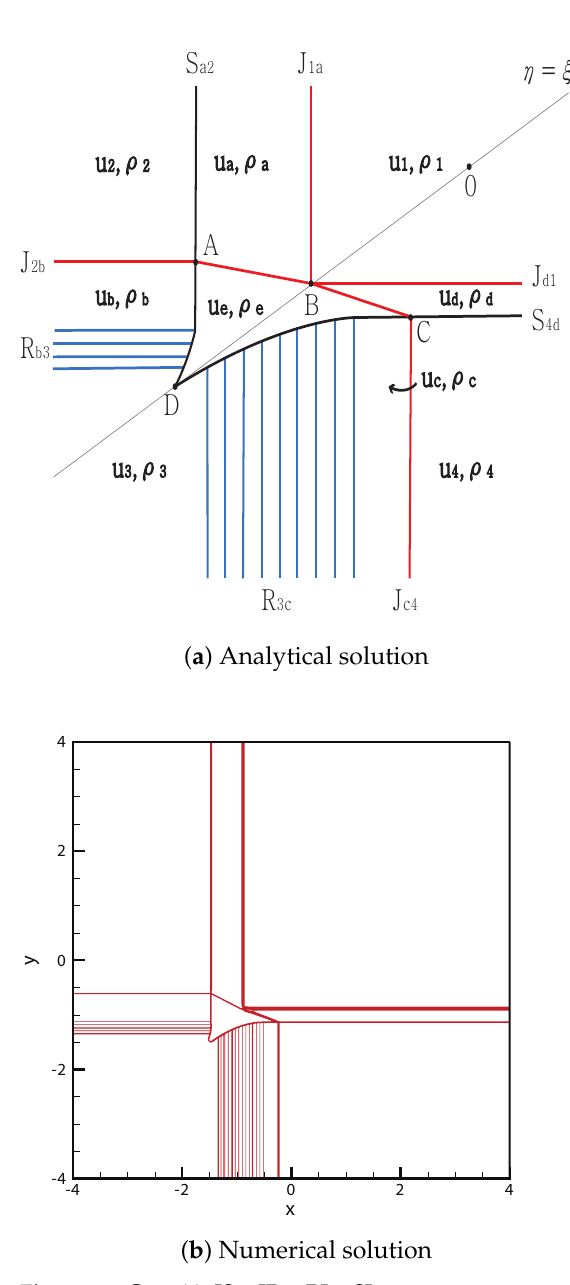
Figure 13. Case 11. JS + JR + RJ +